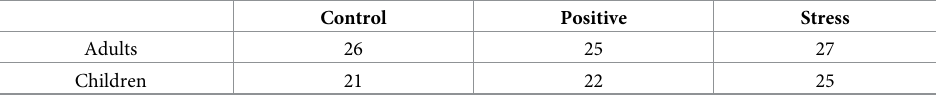
Table 1. Sample sizes, for each age group and condition, after excluding participants for chance performance on the learning